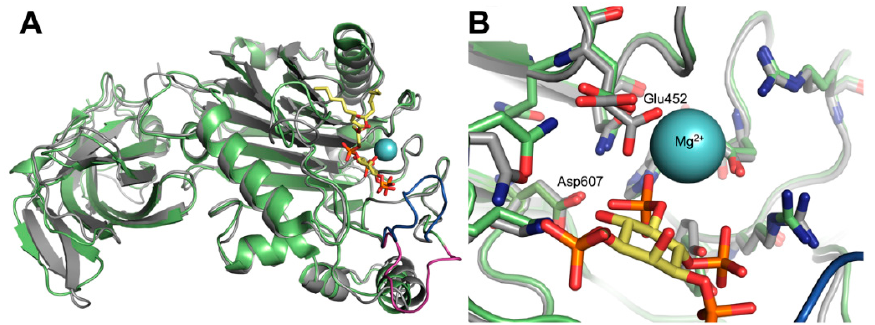
Figure 3. Overlap of X-ray structures of SHIP1 and SHIP2 containing C2 domain and phosphatase domain. ( A ) Structure of SHIP1 (in grey, 6IBD) and SHIP2 (in green, 5OKM) aligned with a model of PI(3,4,5)P 3 constructed as described by Lietha [144], where coordinates for the inositol and metal ion are taken from PDB: 3MTC [146]. The C2 domain is on the left and the phosphatase domain is on the right. In the SHIP1 crystal the P4IM flexible loop region is in the “in” conformation (in blue), while in the SHIP2 crystal structure this portion of the enzyme is in the “out” position (in violet). ( B ) Closeup of the 5’-phosphate binding site from ( A ), SHIP1 in grey, SHIP2 in green. The residues in SHIP1 and SHIP2 have close homology in both structure and position. Some disorder is seen with Glu452 in the SHIP1 structure 6IBD, two conformations are given in the structure, but Glu473 in 5OKM overlaps with one of the conformers and likely can access the other with little difficulty.